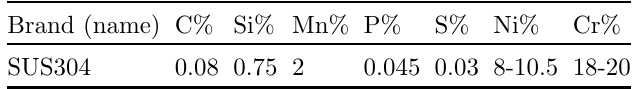
Table 1. Chemical composition of SUS304.